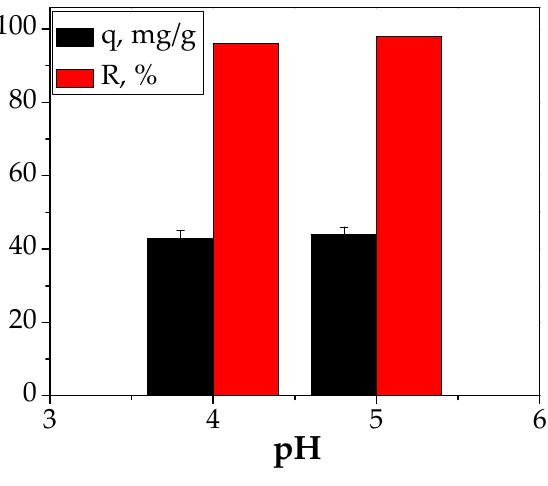
Figure 6. Effect of